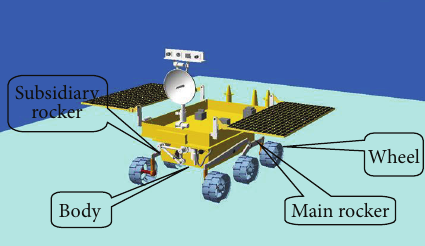
Figure 5: Schematic of six-wheel rocker-type mobile